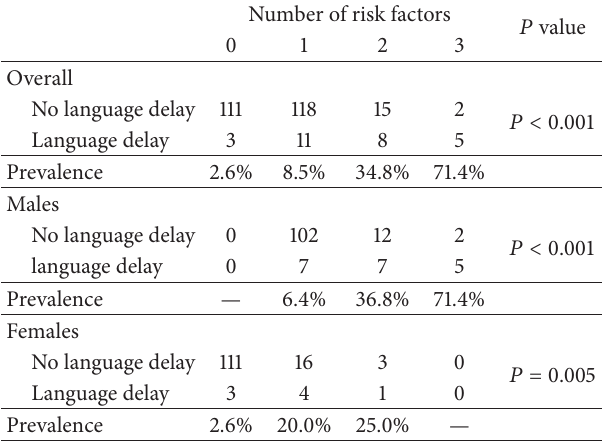
Table 3: Prevalence of language delay at 30 months in relation to number of risk factors, overall and by gender, with Fisher’s exact test 𝑃 values. 𝑁 = 273 (27 with language delay) after excluding 32 children with missing data for one or more risk